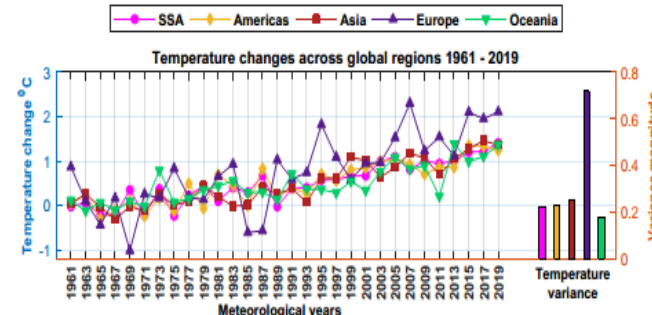
Figure 1. Global temperature changes from 1961 to 2019